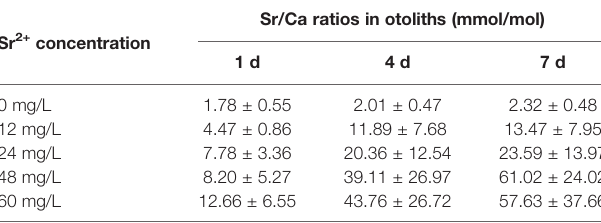
TABLE 2 | Sr/Ca ratios in the strontium-marked otoliths of Coilia nasus larvae in different treatment groups. Sr/Ca ratios in otoliths (mmol/mol) Sr 2+ concentration